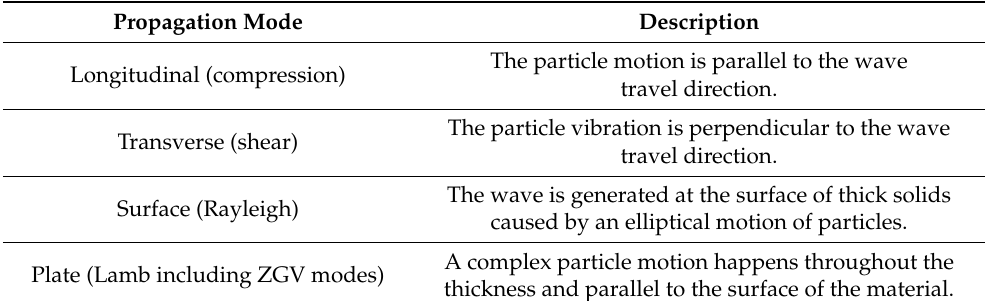
Table 2. The most relevant propagation modes of ultrasonic waves in solids